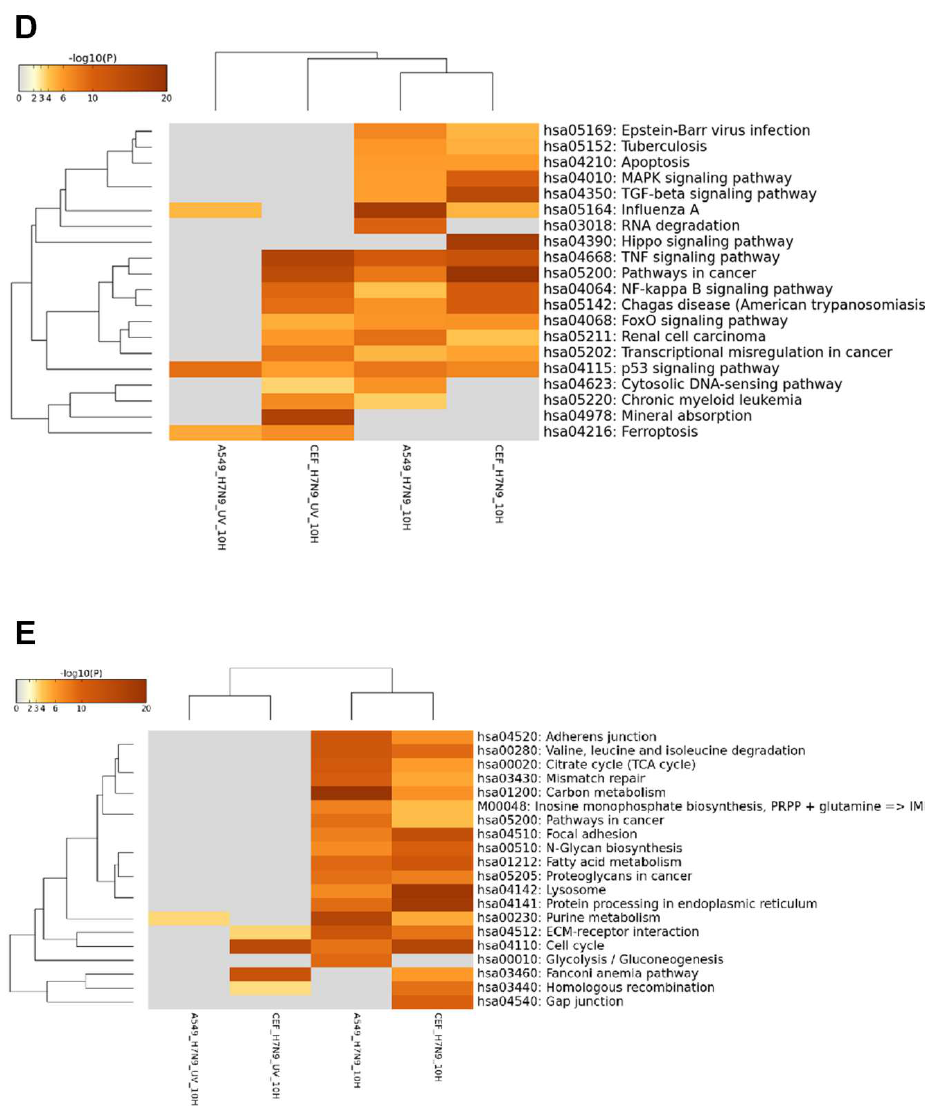
Figure 4. Comparison of orthologous di ff erentially expressed genes (DEGs) in A549 and CEF cells infected with H7N9 virus. ( A ) Principal component analysis of the gene expression changes at 2 and 10 h post-infection (hpi). ( B ) Number of up- and down-regulated orthologus genes in UV-treated and untreated H7N9 virus infections. ( C ) Pairwise analysis of the DEGs at 10 hpi showing (i) up- and (ii) down-regulated genes untreated and UV-treated virus infections. ( D ) Functional annotation of up-regulated orthologous DEG. ( E ) Functional annotation of down-regulated orthologous DEGs.